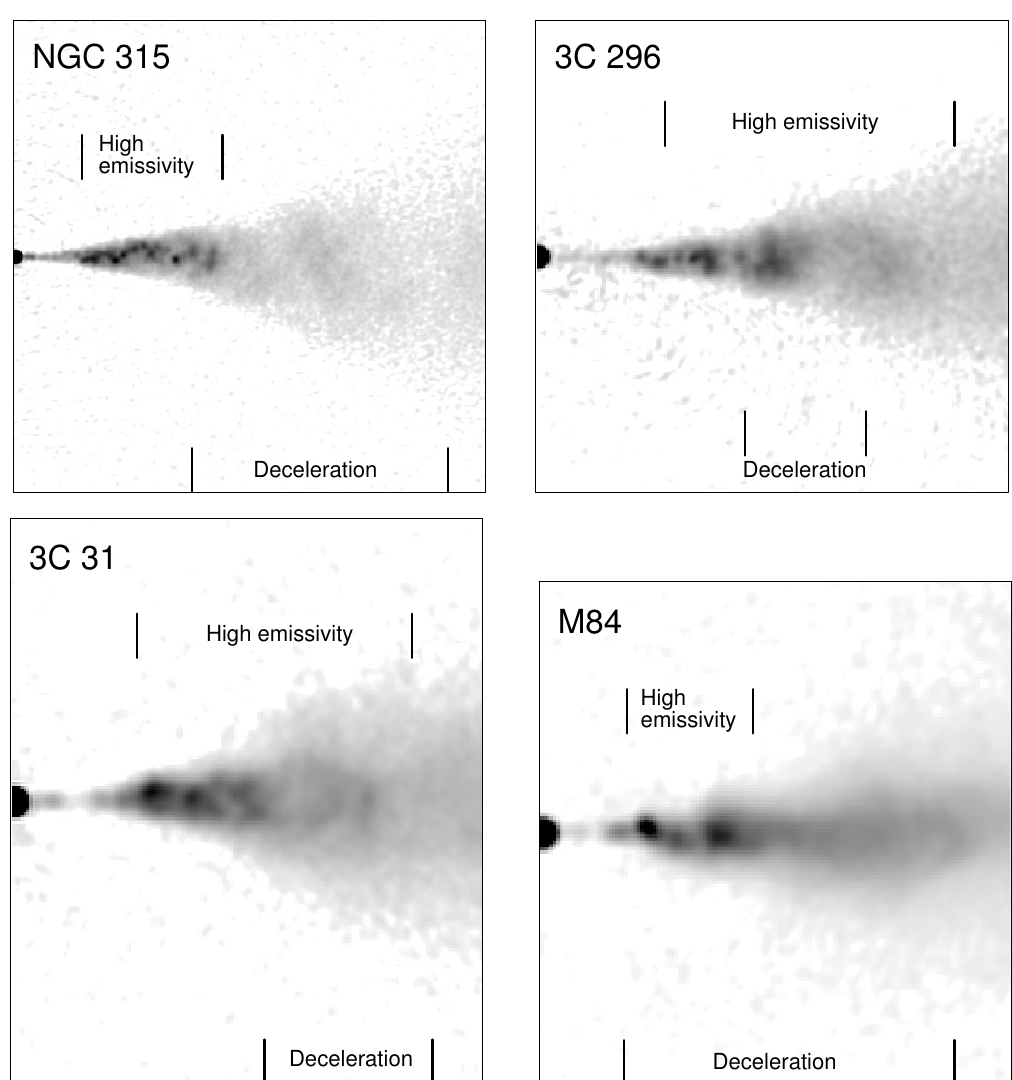
Figure 10. Grey-scale plots of intensity (VLA) for the inner regions of NGC 315 ( top left ), 3C 296 ( top right ), 3C 31 ( bottom left ) and M84 ( bottom right ). The image shows the coincidence of the deceleration region (as obtained from detailed modeling) and those of high-emissivity [27] (courtesy of Robert A.